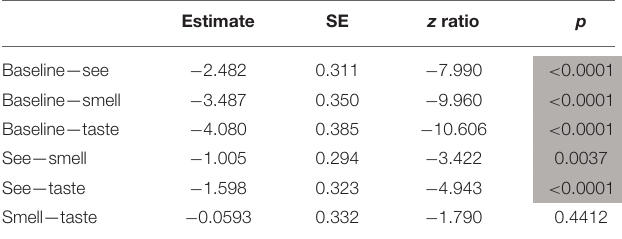
TABLE 3 | Pairwise comparisons for Experiment